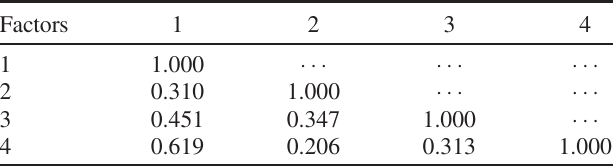
TABLE II. Factor correlation matrix results for EFA utilizing the Kaiser criterion. EFA involved all section 1 students. These factors represent factors whose eigenvalues are over unity after other filtering criteria were applied to the original 30